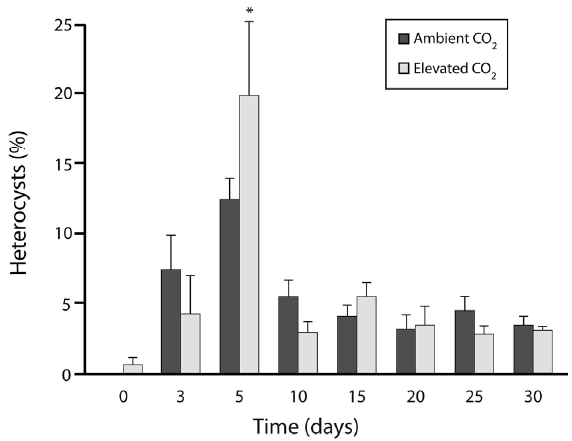
Figure 3. Percent of nitrogen fixing heterocyst cells in cyanobacterial cultures of N. punctiforme over 30 days. Samples were grown on 27 mm diameter agar vials under ambient (430 ppm) and elevated (750 ppm) atmospheric CO 2 conditions. All data are plotted as mean ± SD; pairwise differences are shown using an asterisk symbol (*).